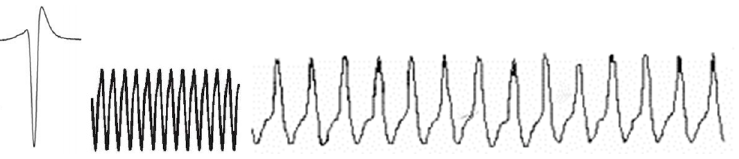
Figure 1. Examples of signature signals used for electroception.